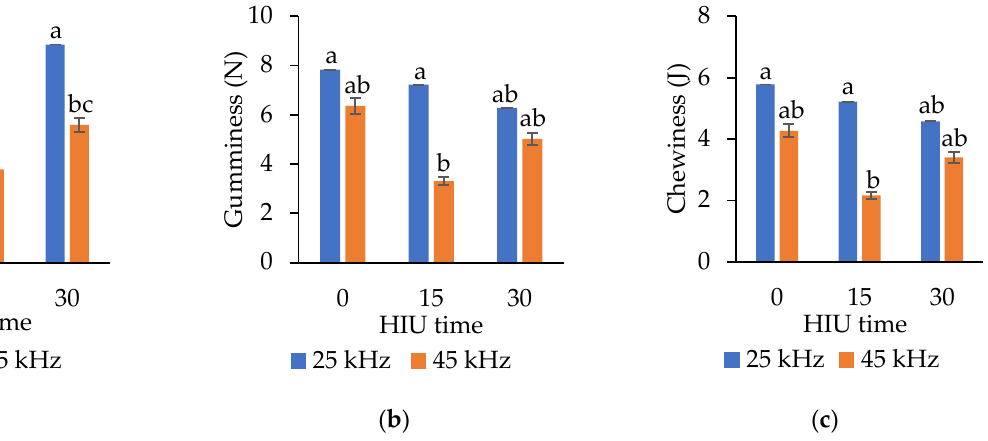
Figure 4. Effects of HIU frequency x application time of raw milk on the hardness ( a ), gumminess ( b ), and chewiness ( c ) of Oaxaca cheese. Data are expressed as mean ± S.D. ( n = 3). a,b,c Different letters in columns within the same graph indicate significant differences between treatments (Tukey’s multiple range tests, assuming a significant difference at p < 0.05, n = 18). The frequency of ultrasonication had a significant effect on the gumminess and chew- iness of Oaxaca cheese (Table 3, p = 0.002 and p = 0.0009, respectively). The ultrasonication time had a significant effect on gumminess ( p = 0.0439). The combination of factors was also significant ( p = 0.0072 and p = 0.0056, respectively). According to Jalilzadeh et al. [12], the cohesiveness and elasticity parameters are closely related to the fat content. Conse- quently, since there were no significant differences ( p > 0.05) in the fat content of cheese caused by the effect of the frequency and time of HIU [13], these properties were not sig- nificant (Table 3). In general, in matured cheeses, the cohesion and elasticity properties tend to remain constant at the end of the storage period [12,38]. Chewability is a property that results from the product of hardness, cohesion, and elasticity. As with hardness, a frequency of 25 kHz produced higher chewiness values (Figure 4c). An increase in the